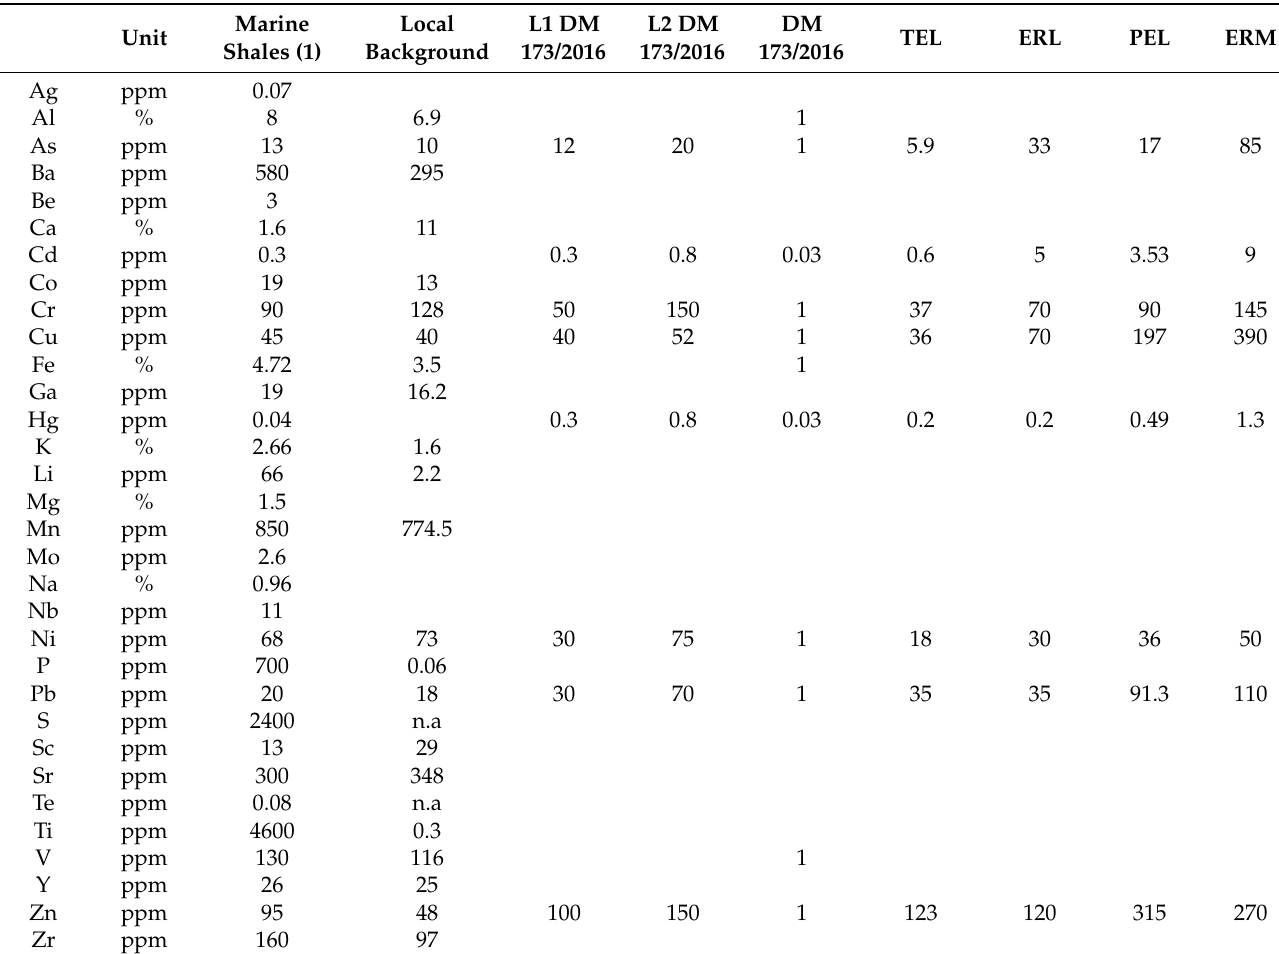
Table 2. Reference values, local background, normative limits and ecotoxicological reference concentrations for the elements investigated in the present study, when available 1